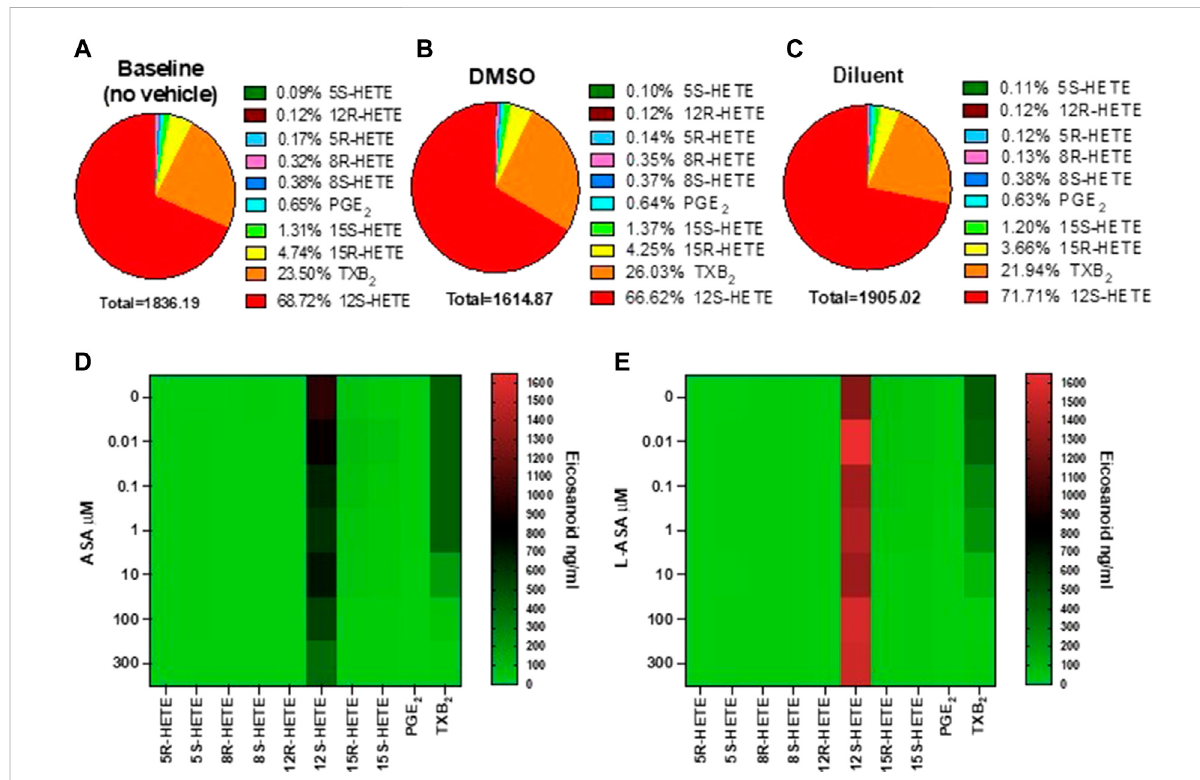
FIGURE 1 Baseline values and the effects of ASA or L-ASA on eicosanoids of human serum generated by targeted chiral lipidomics analysis using LC-MS/ MS. (A – C) Piechartreportingthegenerationofeicosanoidsinserumsamplesobtainedinhumanwholebloodallowedtoclotfor1 hat37 ° Cwithout vehicles (A) and in thepresence of DMSO (ASA vehicle) (B) or diluent(triacetinand saccharin, theconstituents of L-ASA) (C) ;data are the percentage of each eicosanoid versus the total concentration of all eicosanoids obtained by the mean of 6 separate experiments. (D,E) Heat map of the effectofASAandL-ASA(0.01 – 300 μ M),respectively,oneicosanoid(meanvaluesofthreeseparateexperiments)biosynthesisinserum,respectively. As described in the Methods Section, eicosanoid levels were measured by